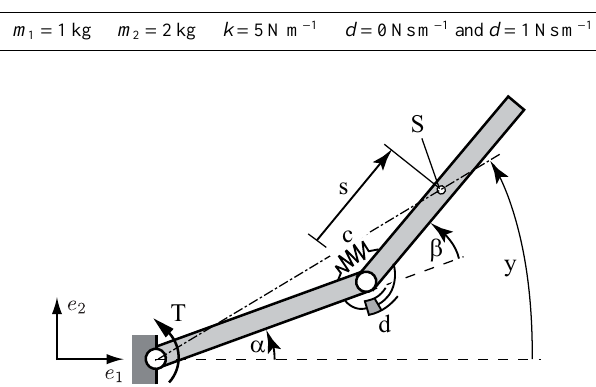
Figure 6. Eigenvalues of zero dynamics for mass on car system.